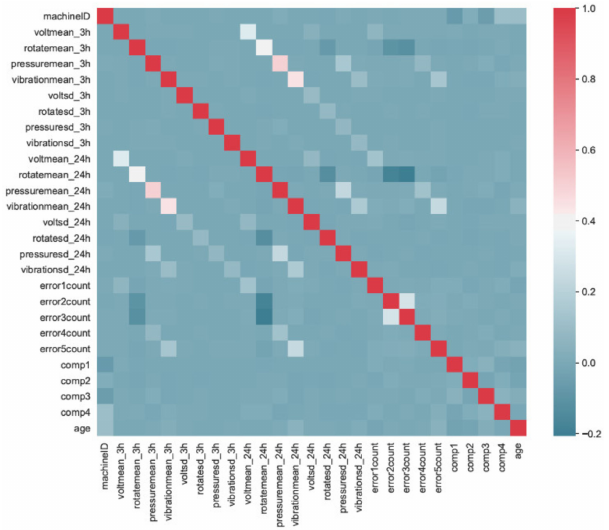
Figure 8. Features